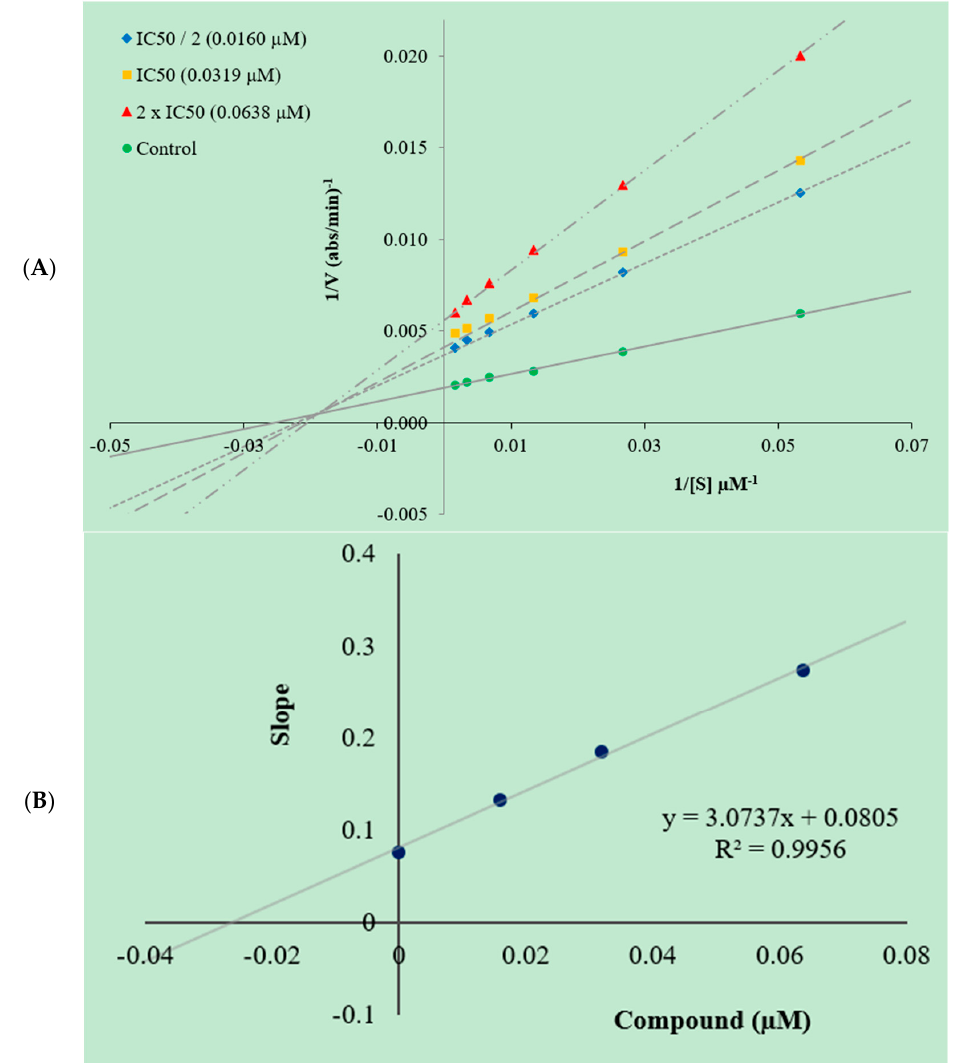
Figure 1. ( A ) Lineweaver-Burk plots for the inhibition of AChE by compound 3d . [S], substrate concentration (µM); V, reaction velocity (abs/min) − 1 . ( B ) Secondary plot for calculation of steady-state inhibition constant (K i ) of compound 3d . Ki was calculated as 0.0262 µM.